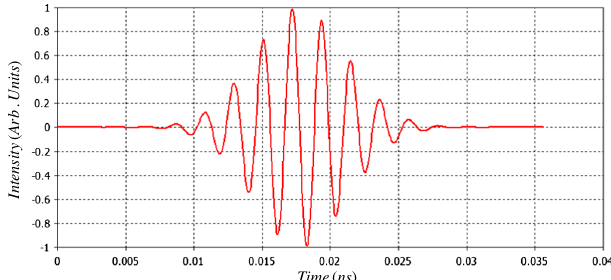
FIG. 18. Temporal profile of 0.465 THz excitation signal with a bandwidth of 100 GHz.